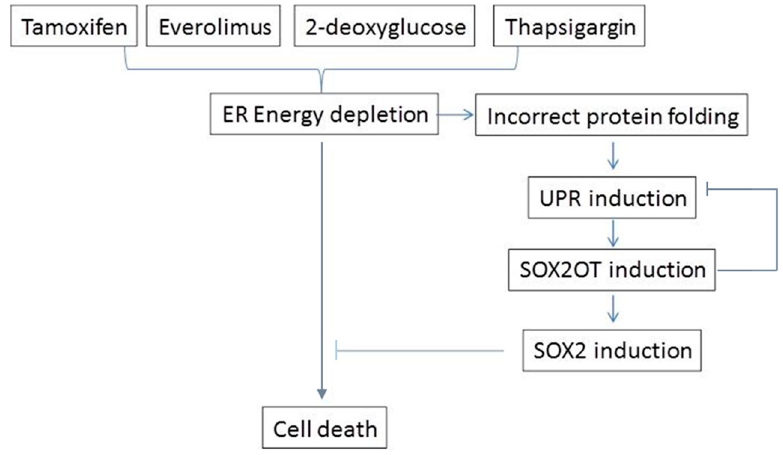
Figure 7. Hypothetical schema of SOX2OT lncRNA and UPR interrelation . Supplementary Materials: The following are available online at www.mdpi.com/xxx/s1, Figure S1: Expression of SOX2OT lncRNA and SOX2 following UPR induction in ER+ breast cancer cell lines, Figure S2: Comparison of SOX2 expression in control and SOX2 over- expressing MDA-MB-231, Figure S1: Figure S1: Table S1: List of primers used in these experi- ments , Table S 2 : Spearman correlation coefficients of relative gene expression for SOX2OT compared to the expression of genes of the UPR pathways in TCGA Her2 neg/pos or Hormone neg/pos samples